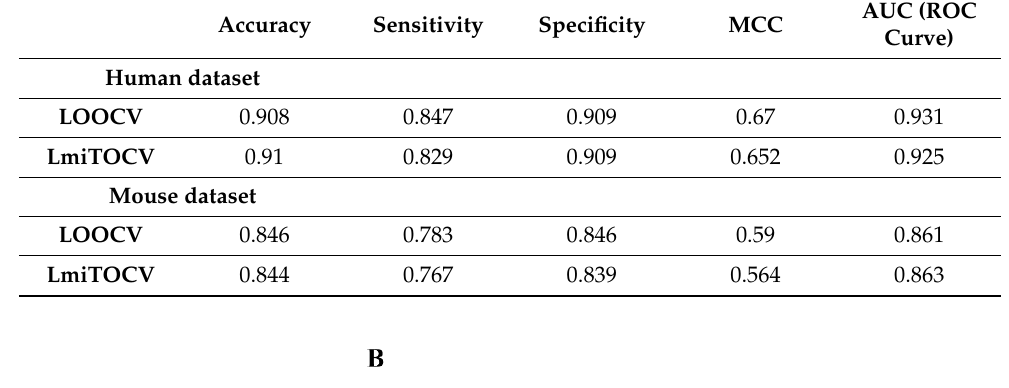
Table 1. Performance measurements of mintRULS by different evaluation parameter using human and mouse datasets. LOOCV: Leave-One-Out-Cross Validation, LmiTOCV: Leave-miTS-Out-Cross- Validation, ROC: Receiver Operating Characteristics, AUC: Area Under Curve, MCC: Matthews correlation coefficient. Accuracy Sensitivity